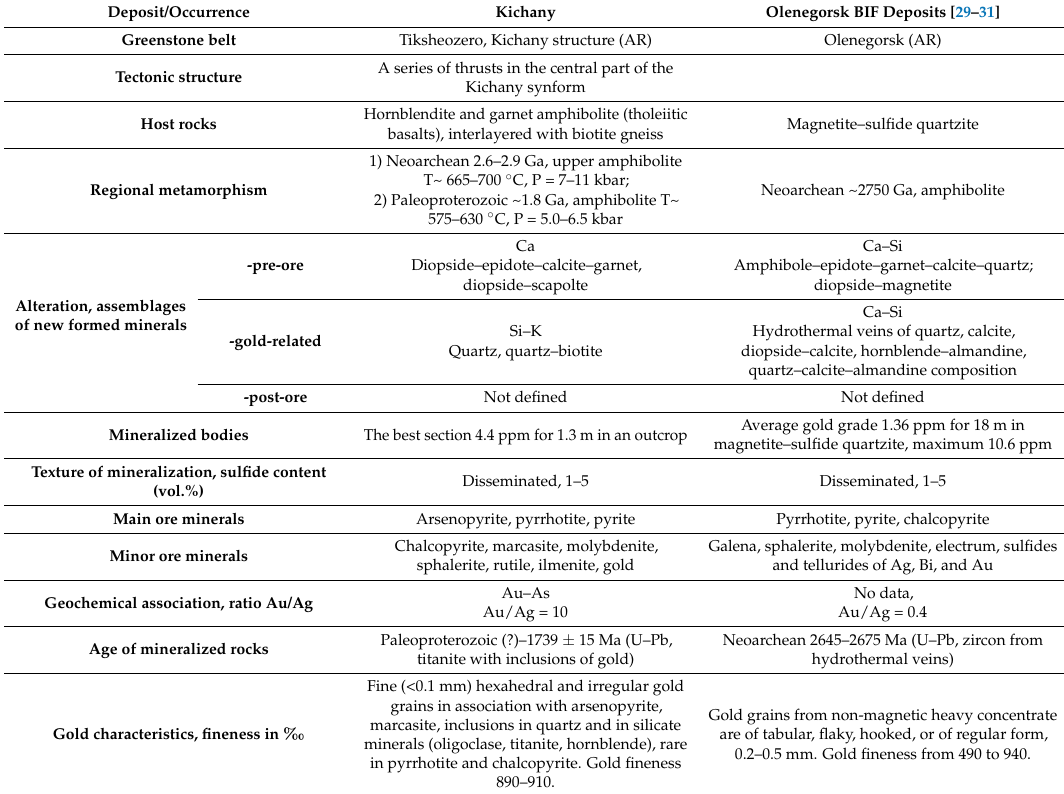
Table 7. General characteristics of gold occurrences in the Tiksheozero and Olenegorsk greenstone belts.